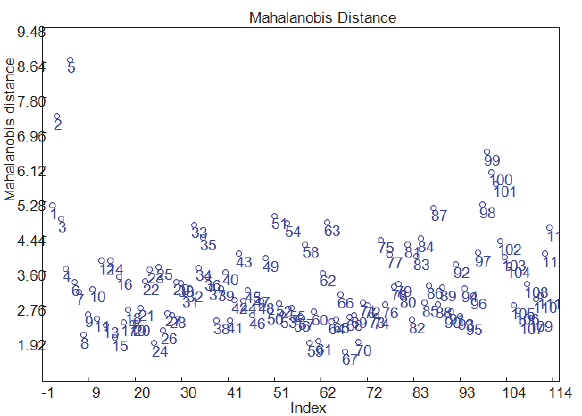
Figure 4: Hat matrix method analysis of all